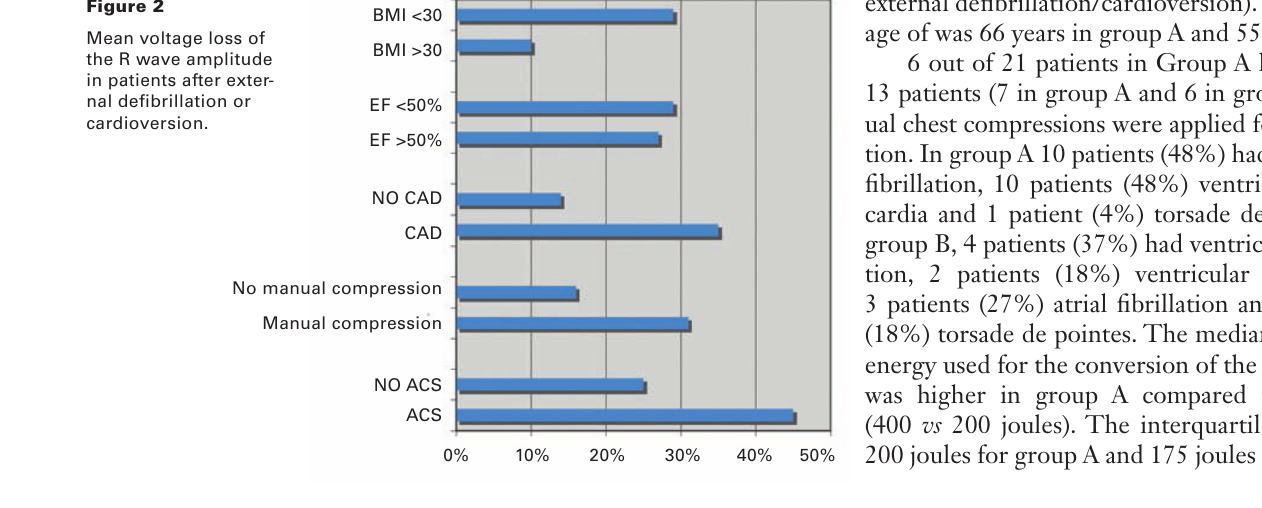
Mean voltage loss of the R wave amplitude in patients after exter- nal defibrillation or